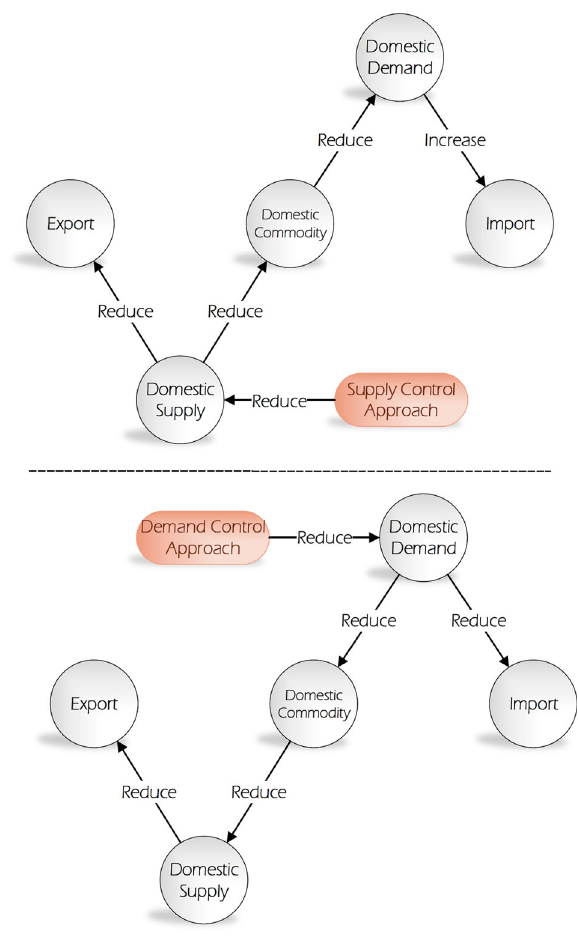
Fig. 12 Key fi ndings of this paper. The arrow represents the chain of in fl uence (increase/positive or